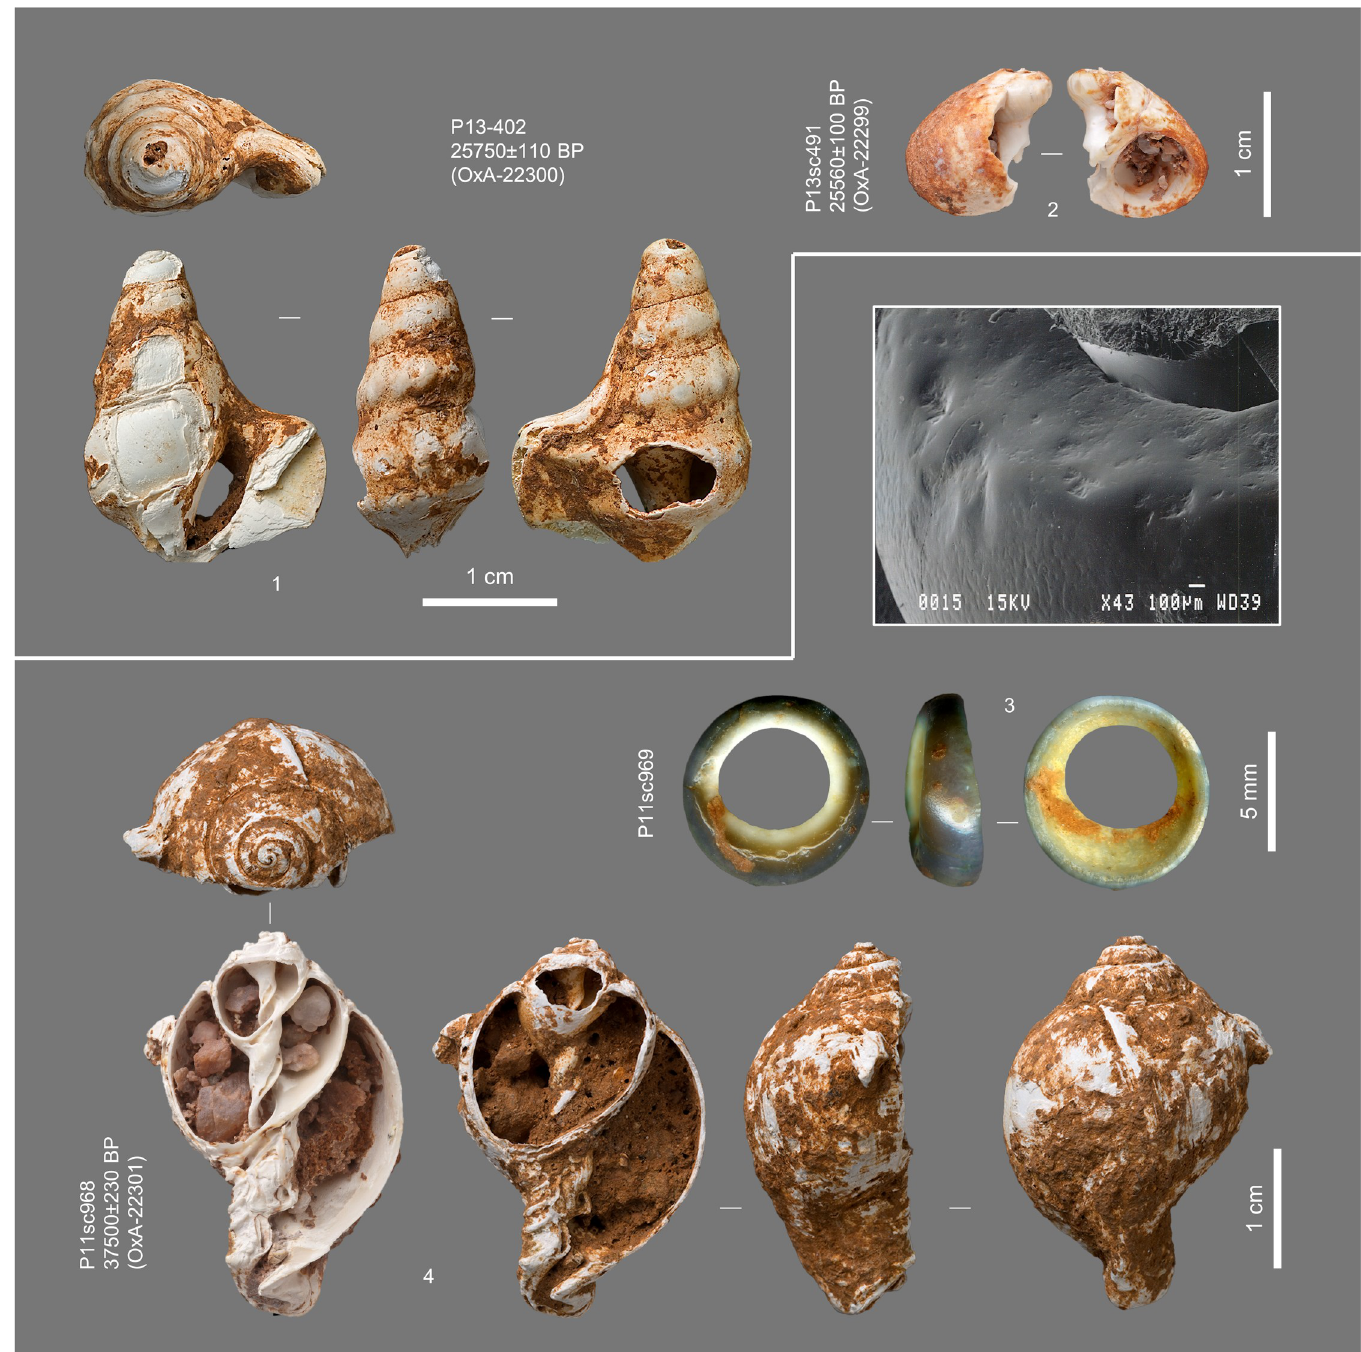
Fig 12. Personal ornaments in layers Jb-K and their radiocarbon ages. 1. Perforated Aporrhais pespellacani shell. 2. Broken Littorina obtusata shell. 3. Worn-down Sparus auratus tooth (undated) and SEM image of the natural wear of the occlusal surface. 4. Eroded Semicassis saburon shell (leftmost ventral view taken after removal of the infill, showing the characteristic coarse sand/small pebble matrix of its layer of provenance). Nos. 1 and 2 are from layer Jb, nos. 3 and 4 are from layer K.